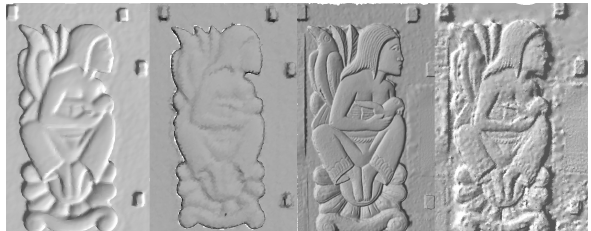
Figure 8: Visual quality check from left to right Carmine 1.09, Kinect, DCC and webcam with